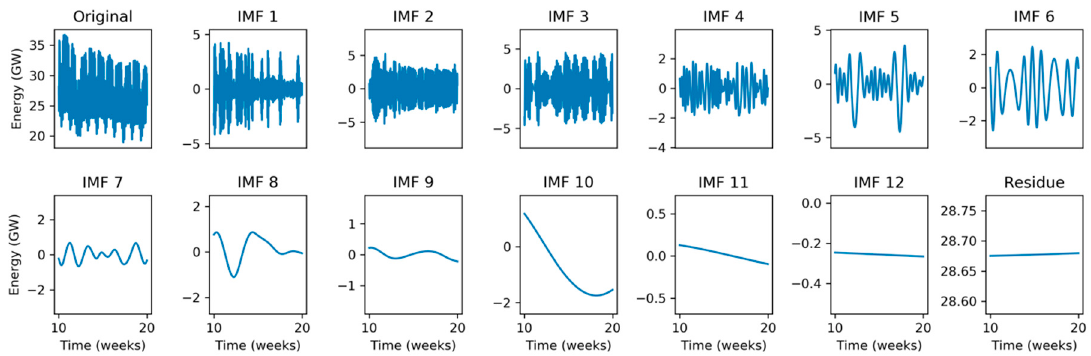
Figure 8. Empirical Mode Decomposition of the electricity demand: Weekly scale.